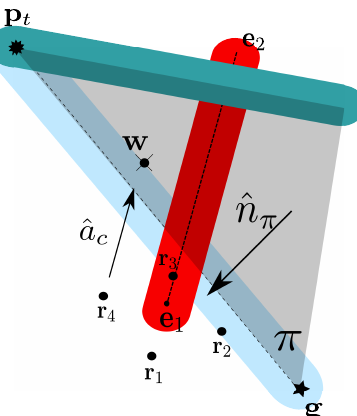
Figure 4. In red: an obstacle. In blue: the tool. In light-blue: the goal pose. In grey: the plane π determined by the actual pose of the robot and the goal pose. The figure above shows the points r i around the obstacle, for which the point within them is chosen, and how it is projected onto the plane in order to get the waypoint w